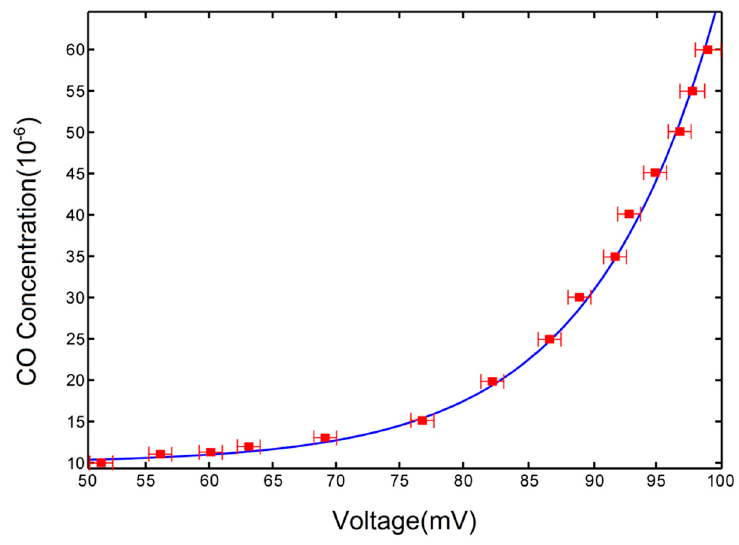
Figure 3. Concentration of CO versus output voltage of the sensor